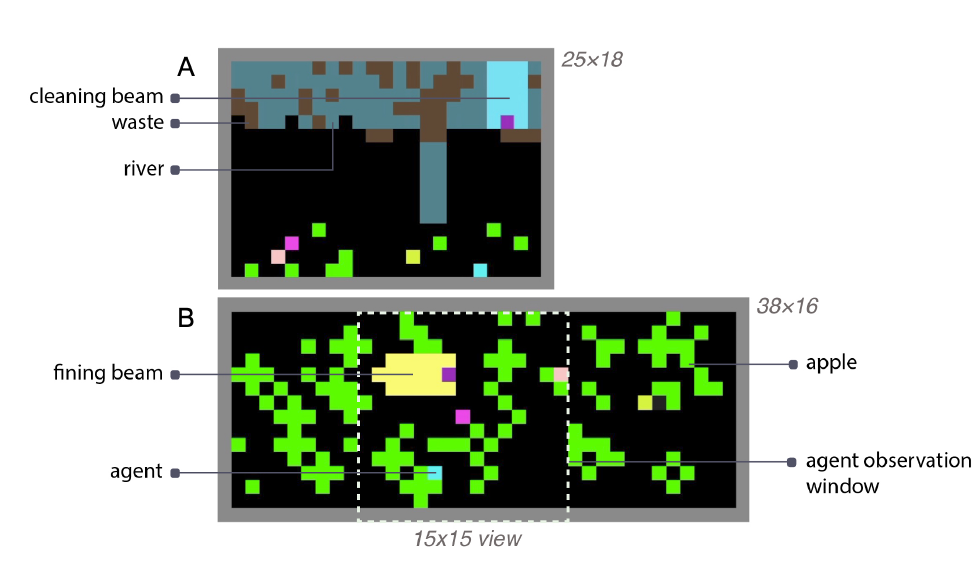
Figure 3. ( A ) is the Cleanup and ( B ) is the Harvest. Green grids represent apples, and the agent collects rewards by reaching green square locations. Blue and yellow represent cleaning beams and punishment beams,